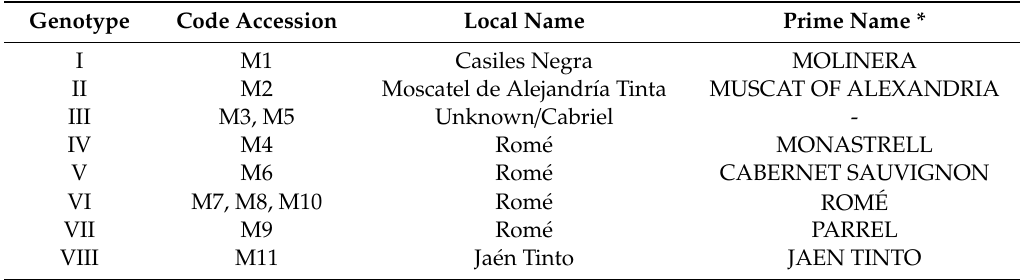
Table 2. Genotypes identified for the 11 grapevine accessions characterized at 25 microsatellite loci. Genotype